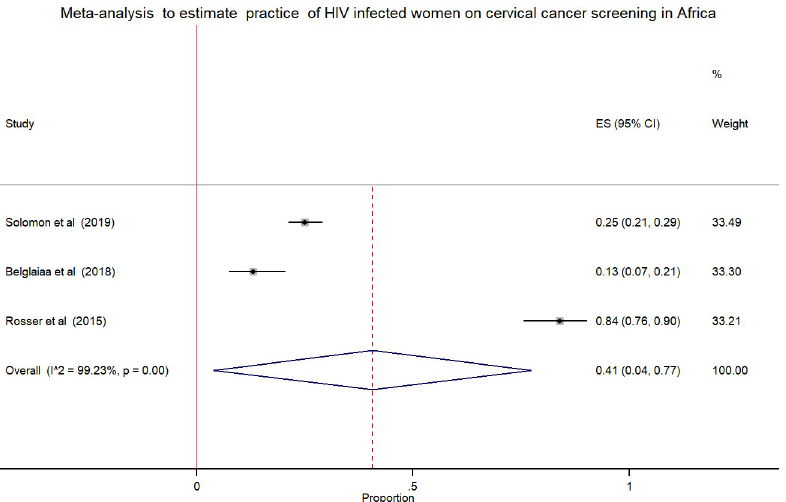
Fig 4. Forest plot to estimates the proportion of practice among HIV infected women towards cervical cancer screening in Africa with 95% CI (the estimate weighted based on random effects model): ES-Effect size equivalent to the proportion, CI-Confidence interval. In the plot, the diamond shows the pooled result and the boxes show the effect estimates from the single studies. The purple dotted vertical line indicates pooled estimate. The purple solid vertical line indicates the reference line at zero indicating no effect. The horizontal line through the boxes illustrate the length of the confidence interval and the boxes show the effect estimates from the single studies.